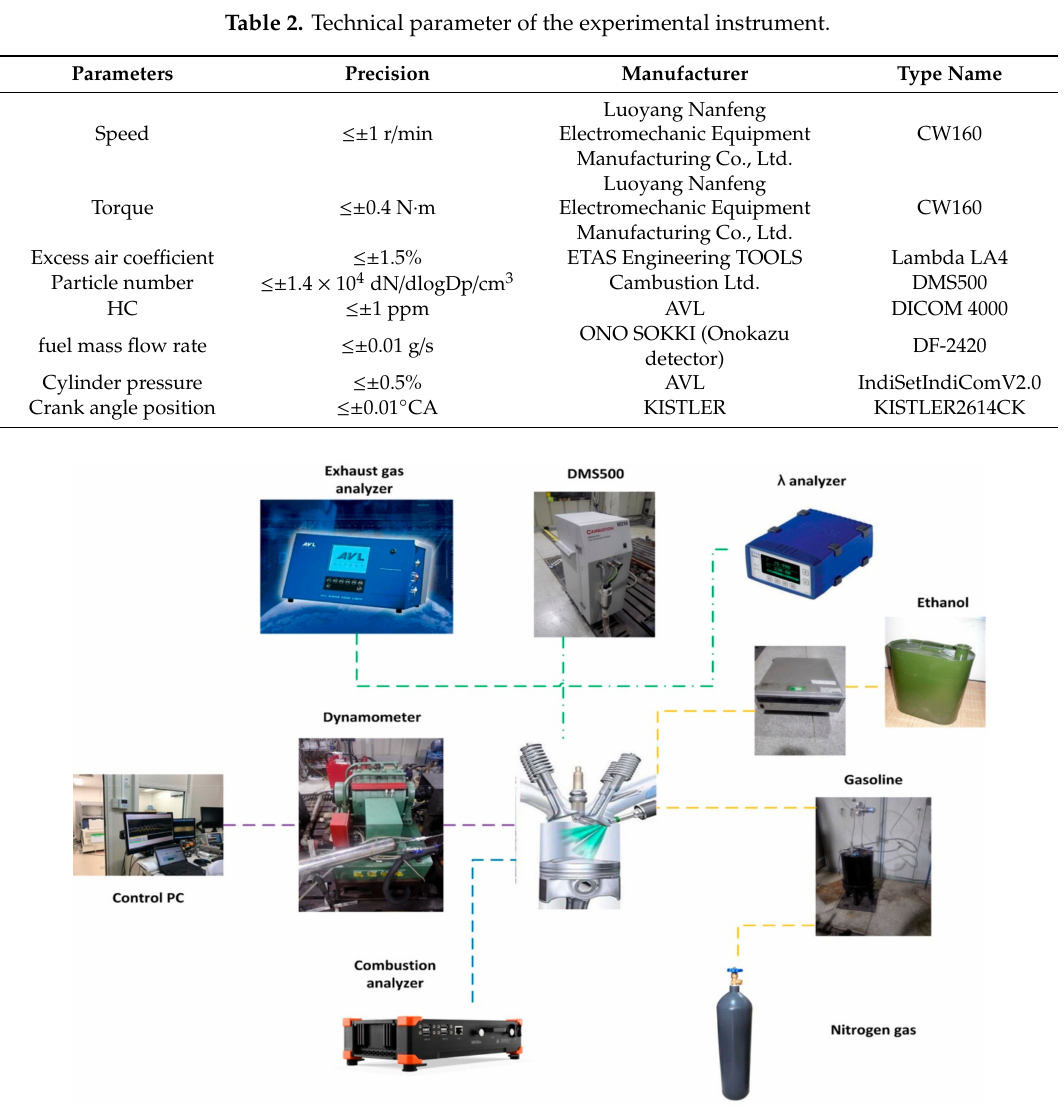
Figure 1. Engine and instrument